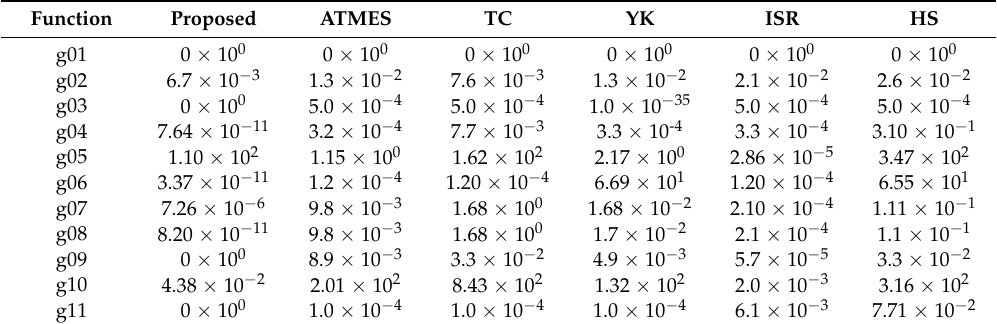
Table 2. The differences between optimal values from the six algorithms and the ground